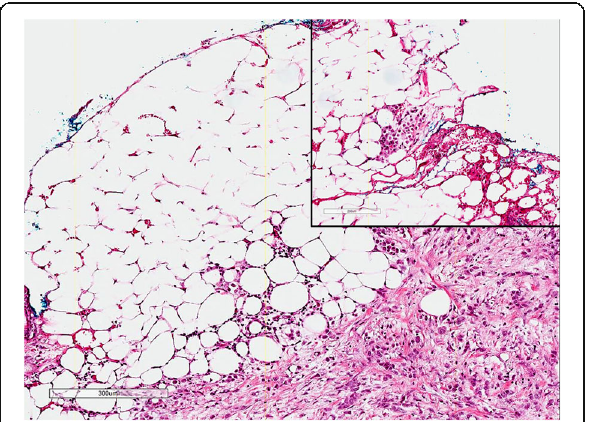
Fig. 5 Common aspect present in plasmocytoid urothelial carcinoma, infiltration of the fat tissue reaching the radial surgical